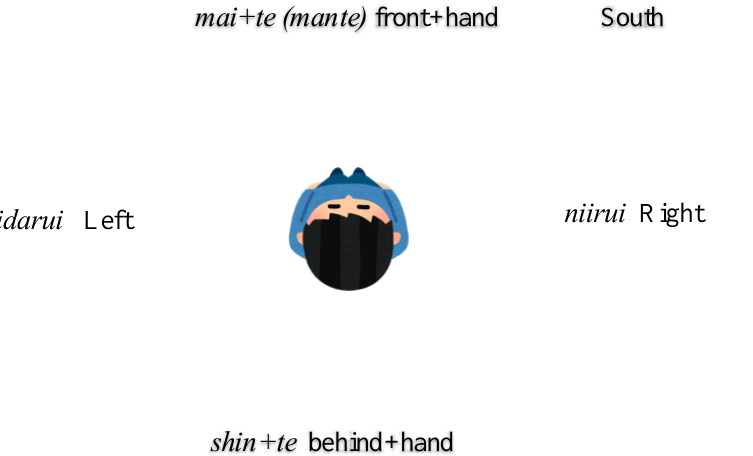
Figure 5. House system inside the home (Aragusuku). Very close at hand (sitting or standing inside).